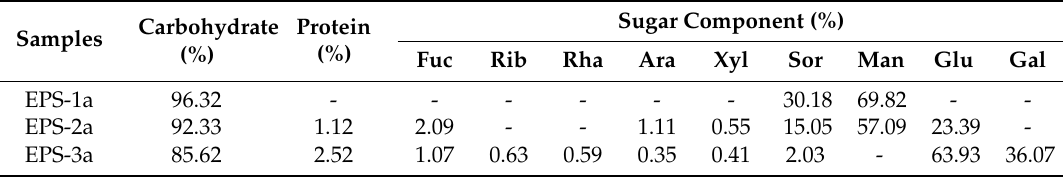
Figure 4. The GC profiles of standard monosaccharides ( a ), EPS-1a ( b ), EPS-2a ( c ), and EPS-3a ( d ) determined by GC system. Table 1. Preliminary characterization of EPS-1a, EPS-2a, and EPS-3a.